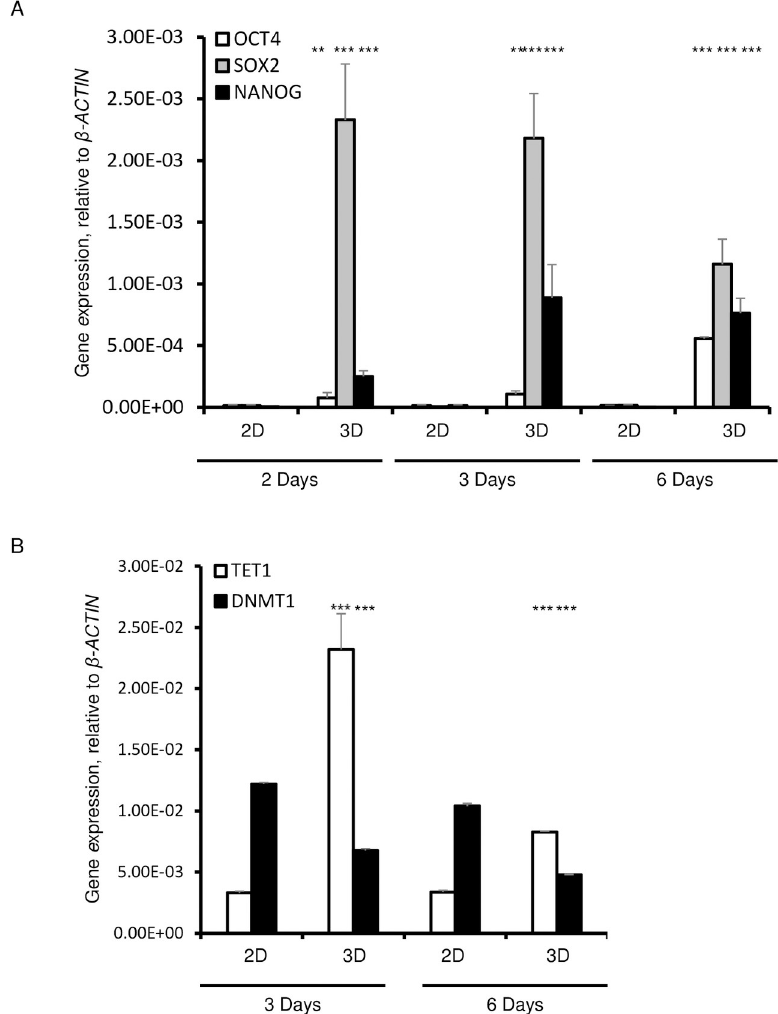
Fig 2. Expression of pluripotency markers, OCT4 , SOX2 , and NANOG in 3D spheroids cultured for 2, 3, and 6 days. A. qPCR of OCT4 , SOX2 and NANOG . B. q PCR analysis of TET1 and DNMT1 . Data are presented as the means ± SD from 3–6 independent experiments. β -ACTIN was used as a housekeeping control. Statistical significance is shown as � (p � 0.05), �� (p � 0.005), and ��� (p � 0.0005) in 3D as compared to 2D cultured cells.